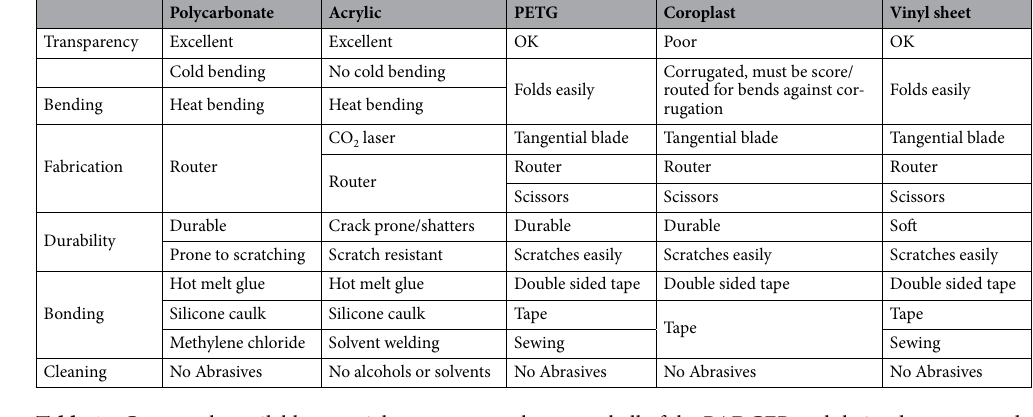
Table 1. Commonly available materials to construct the outer shell of the BADGER and their advantages and disadvantage in manufacturing and clinical